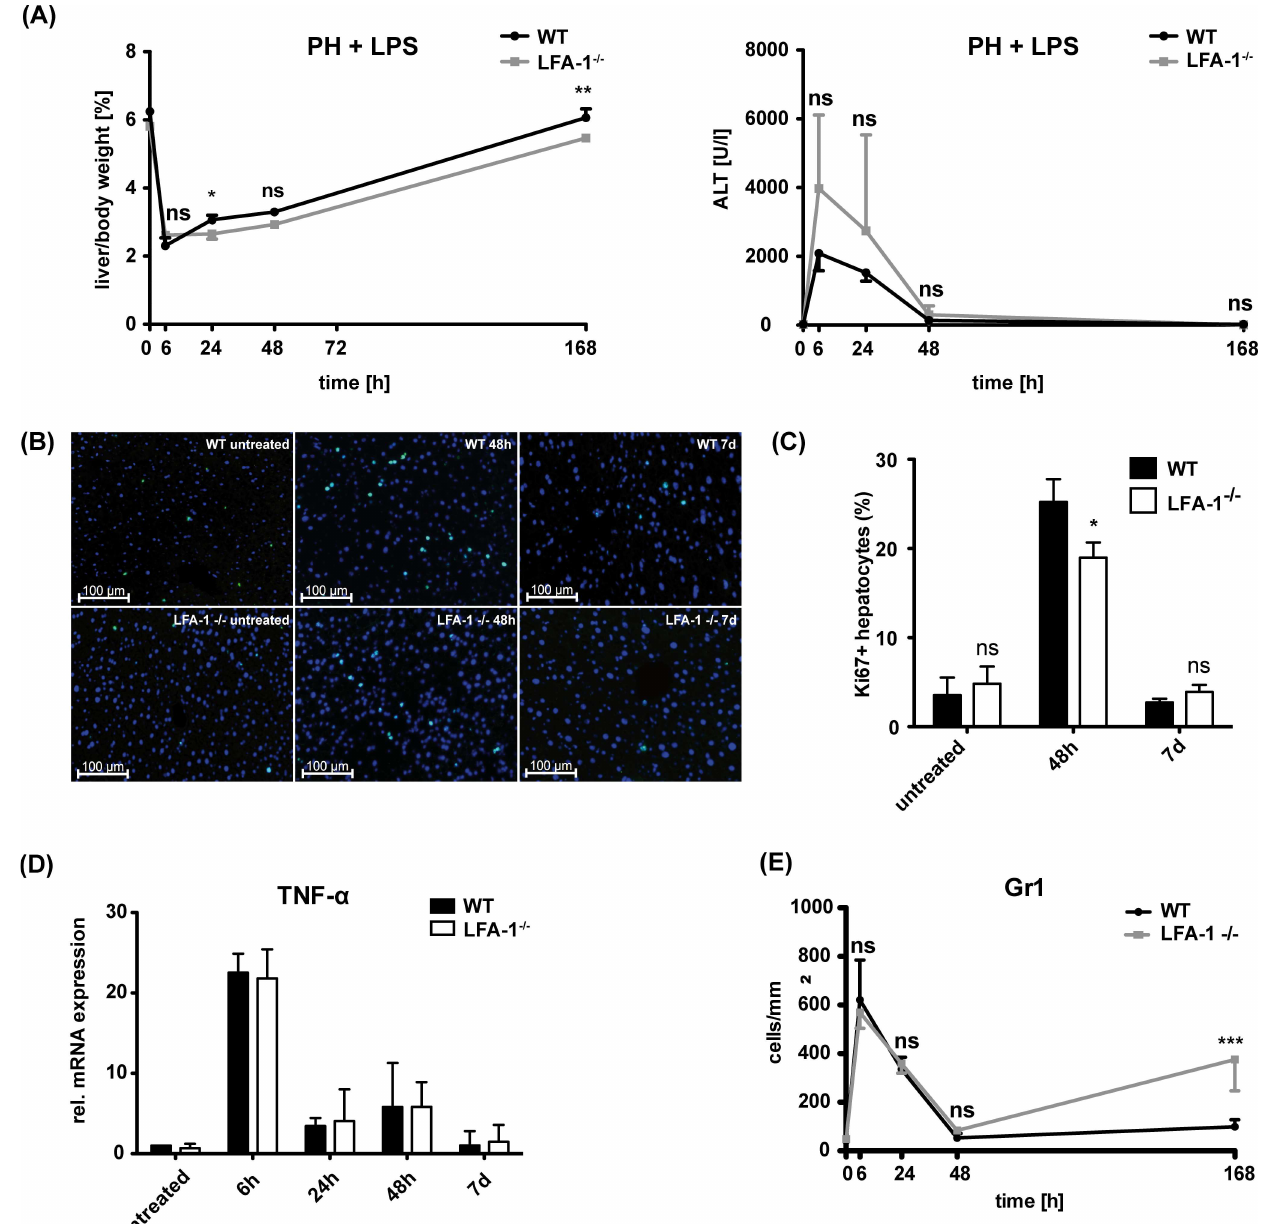
Fig 3. Impact of LFA-1 on liver regeneration. (A) Liver/body-weight-ratioin percent and amount of ALT in the serum of WT or LFA-1 -/- mice at different time points upon PH and application of 50 μ gLPS per 20g body weight. Values represent mean ± SD from 3 mice per time point. Statistical significances were analyzedby two-way ANOVA-test and refer to the comparisonbetweenthe WT and LFA-1 -/- mice. (B) Detection of proliferating Ki67-positive hepatocytesin the liver parenchymaat 48h and 7 days in the liver parenchyma of WT or LFA-1 -/- mice. Scale bars indicate100 μ m.Ki-67 (green), nuclear DAPI (blue). (C) Mean ± SD of Ki-67 positive hepatocytesin relationto all hepatocytesin percent is shown. At least 5 cryosections for each time point from two mice (n (cid:21) 2000hepatocytes)were analyzed.(D) Analysis of TNF α -mRNA uponPH and low-doseLPS in the liver parenchyma of WT and LFA-1 -/- mice. Valuesrepresent mean ± SD from 3 mice per time point. Statistical differences betweenWT and LFA-1 -/- were tested by two-way ANOVA-test. (E) Quantification of Gr1 + neutrophilsin the liver parenchyma after PH and LPS applicationby immunofluorescencestaining on liver cryosections.Values represent mean ± SD from at least 5 cryosectionsfor each time point (n = 3 mice). Statistical differencesbetweenthe WT and LFA-1 -/- were tested by two-way ANOVA-test.